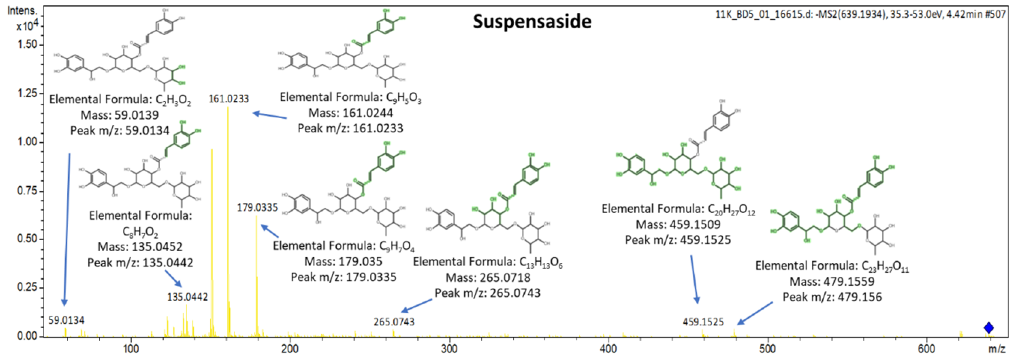
Figure 15. Spectra and MS / MS fragments of suspensaside.